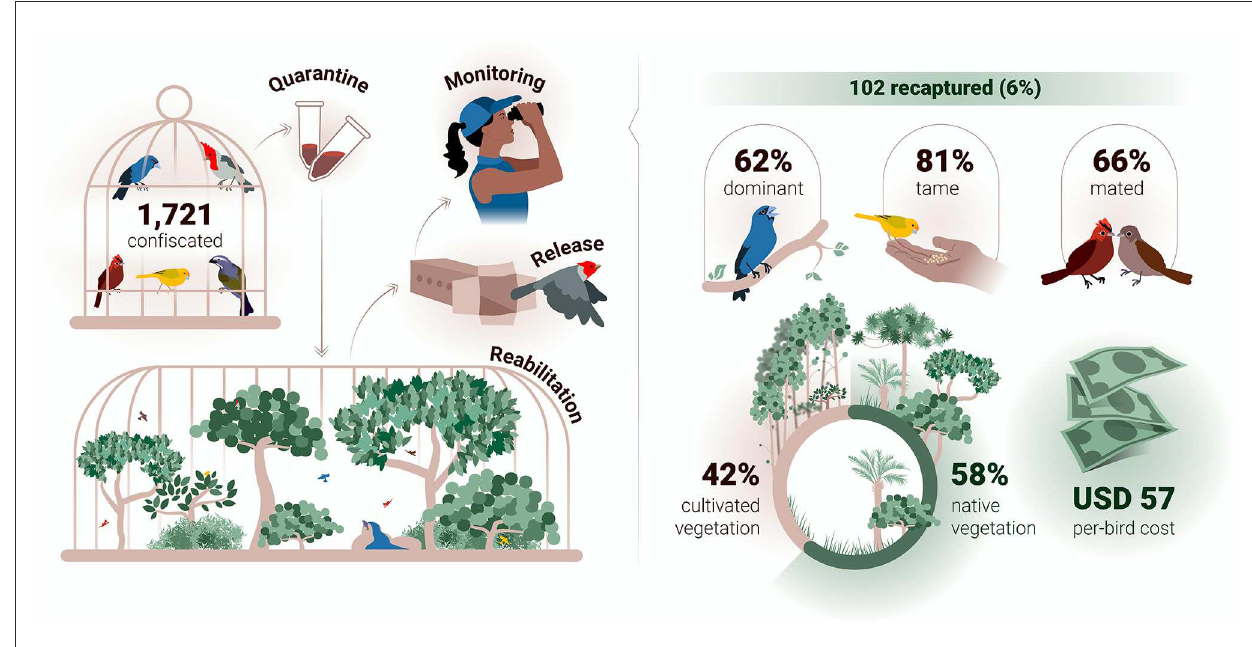
FIGURE1 Graphical